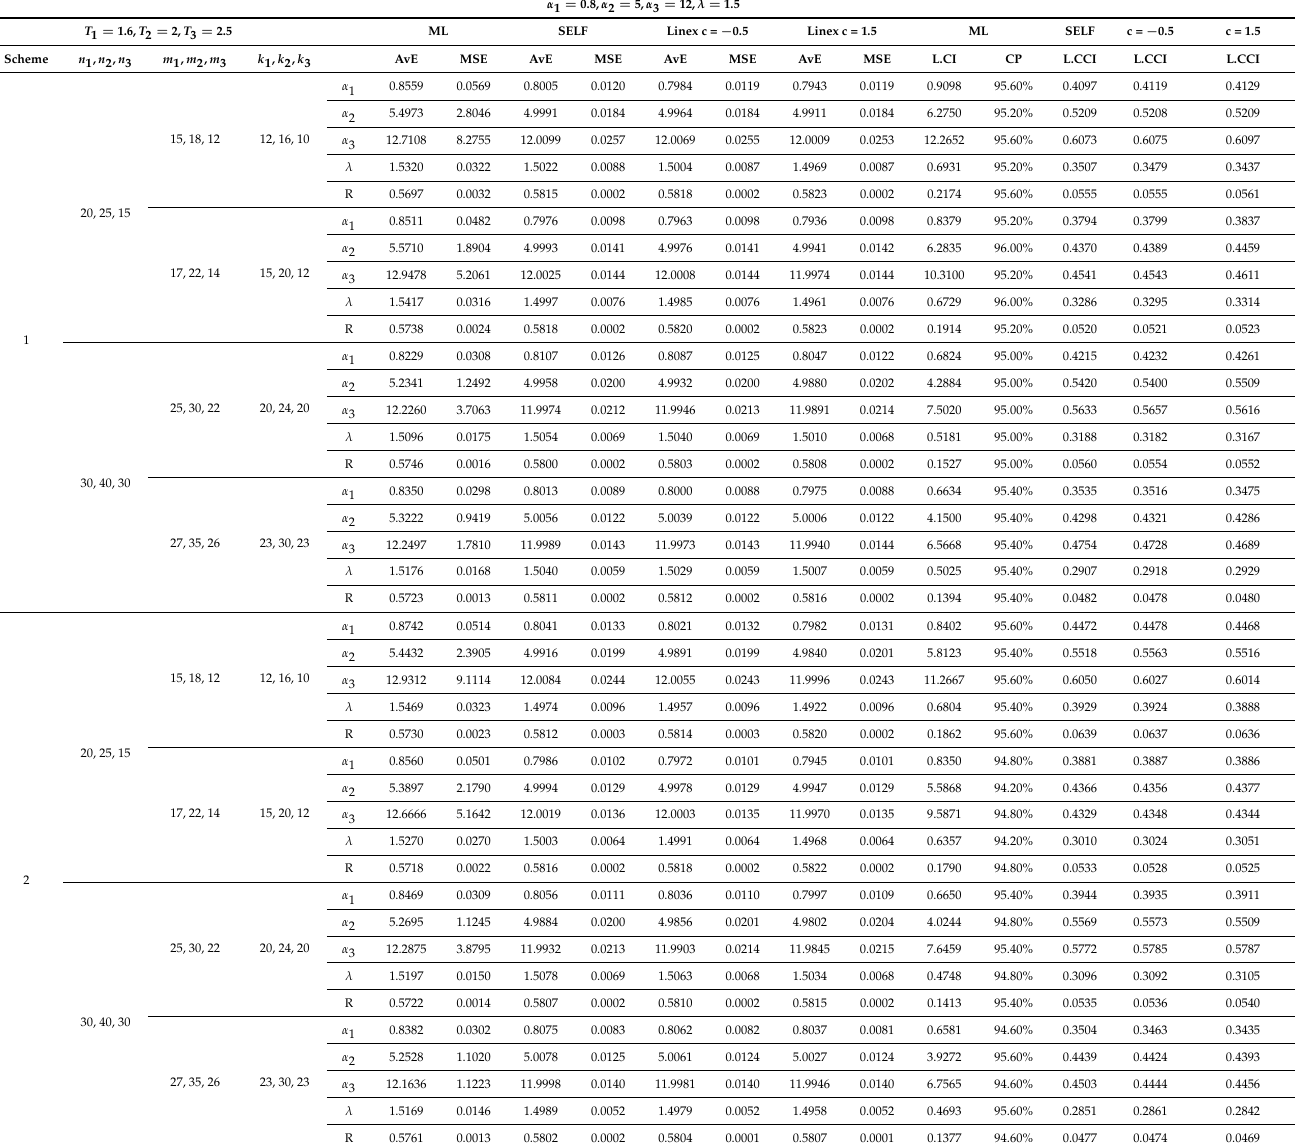
Table 3. AvE and MSE for estimation methods: Case